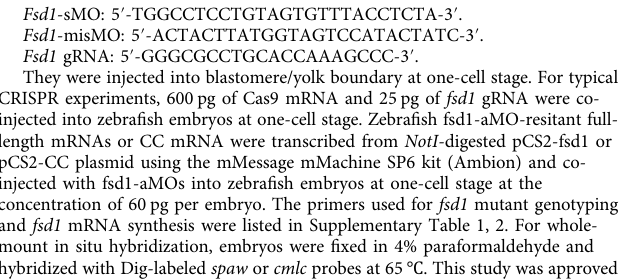
Fig. 7 CAP350-FOP complex are essential for FSD1 centrosome localization. a Effects of depletion of known 12 anchoring proteins on the FSD1 localization at centrosomes. RPE-1 cells were transfected with indicated siRNAs and stained with antibodies to FSD1 (green) and γ -tubulin (red). Bars indicate the median. Signi fi cance between two groups was determined by two-tailed t -test. *** P < 0.001. Scale bar, 500 nm. b Immuno fl uorescence analysis of the relationship between FSD1 and the CAP350-FOP complex. RPE-1 cells transfected with the indicated siRNAs were stained with antibodies to CEP19, CAP350, or FOP (green), and to Centrin2 (red). Scale bar, 500 nm. c Immunoprecipitation and immunoblot analysis of the interaction of Flag-FSD1 with endogenous FOP, CAP350, and CEP19 in HEK293T cells. HEK293T cells were transfected with Flag-tagged FSD1; lysates immunoprecipitated with anti- Flag, as well as input lysates, were analyzed by immunoblot with indicated antibodies. d The interaction between endogenous FSD1 and CAP350, FOP in RPE-1 cells. Immunoblot analysis of lysates of RPE-1 cells immunoprecipitated with anti-FSD1, anti-CAP350, anti-FOP, or control IgG. e Model depicting the interactions between FSD1 and the CAP350-FOP complex. The size of arrowhead represents the affected strength on corresponding